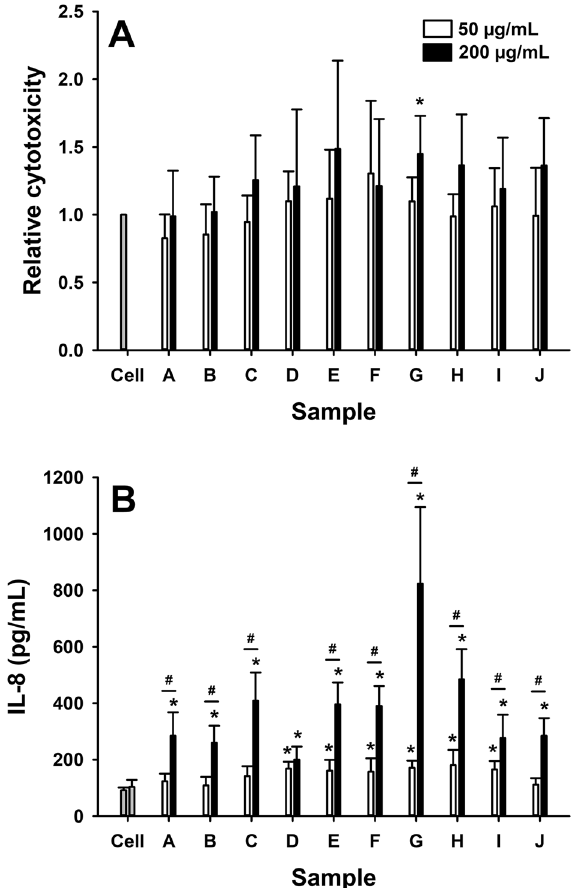
Figure 2. Relative cytotoxicity ( A ), measured as LDH release relative to control (cell only), and IL-8 production, measured in the cell supernatant by ELISA, in epithelial cells (A549) in response to 24 h exposure to 50 µg/mL (white bars) or 200 µg/mL (black bars) of coal particles (samples A–J). Data are presented as mean (SD). *p < 0.05, versus cell only; # p < 0.05, 200 µg/mL vs 50